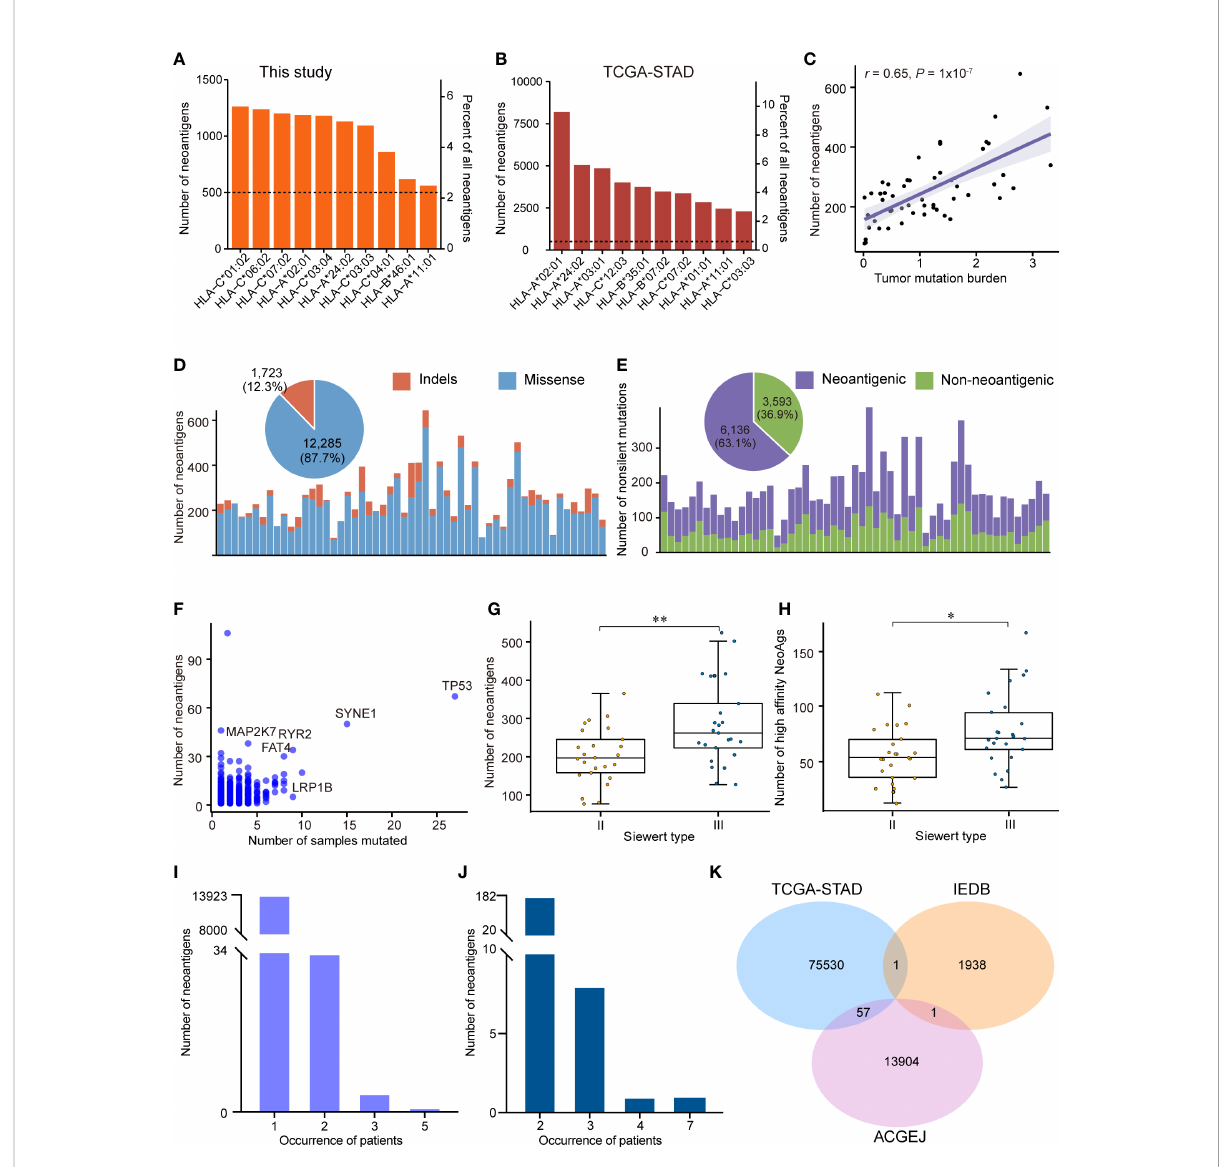
FIGURE 4 The neoantigen landscape in ACGEJ. (A, B) Ten predicted neoantigen sites of our ACGEJ samples (A) and TCGA-STAD samples (B) . (C) Correlations between neoantigen load and tumor mutation burden (Spearman ’ s correlation test). (D) Bar plots showing the number of neoantigens for each individual and their variant types. The pie plot on the top shows the fraction of variant types that produced neoantigens in 55 ACGEJ samples. (E) Bar plot and pie plot displaying the composition of nonsilent mutations that produced neoantigens. (F) Frequently altered genes with a high ability to generate neoantigens. The graph displays the number of samples containing speci fi c genetic mutations and the relevant number of neoantigens. (G, H) Number of neoantigens (G) and number of high-af fi nity neoantigens (H) in different ACGEJ Siewert types. P values were derived from Wilcoxon rank-sum tests. NeoAgs: neoantigens. (I, J) Neoantigen recurrence in our patients (I) and TCGA- STAD patients (J) . (G) Venn diagram displaying the intersections of neoantigens from our ACGEJ patients, TCGA-STAD patients and